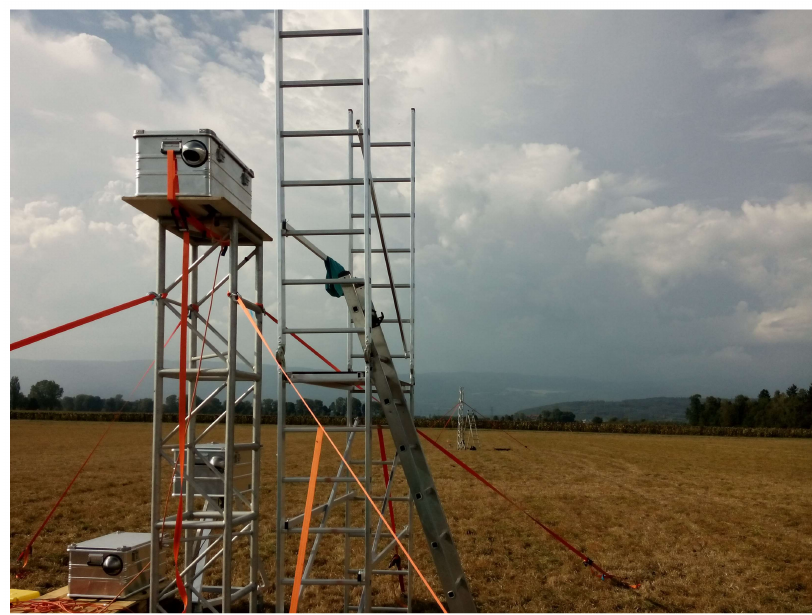
Figure 3. Three miniDOAS instruments located at the release site, 15 m downwind of the source center (position near ). The distances between the boxes containing the light source and the detector (picture foreground) and the reflectors (picture background) were approx. 35 m. The measurement heights were 0.5 m ( near / bottom ), 1.25 m ( near / middle ), and 3.0 m ( near / top ) above ground.